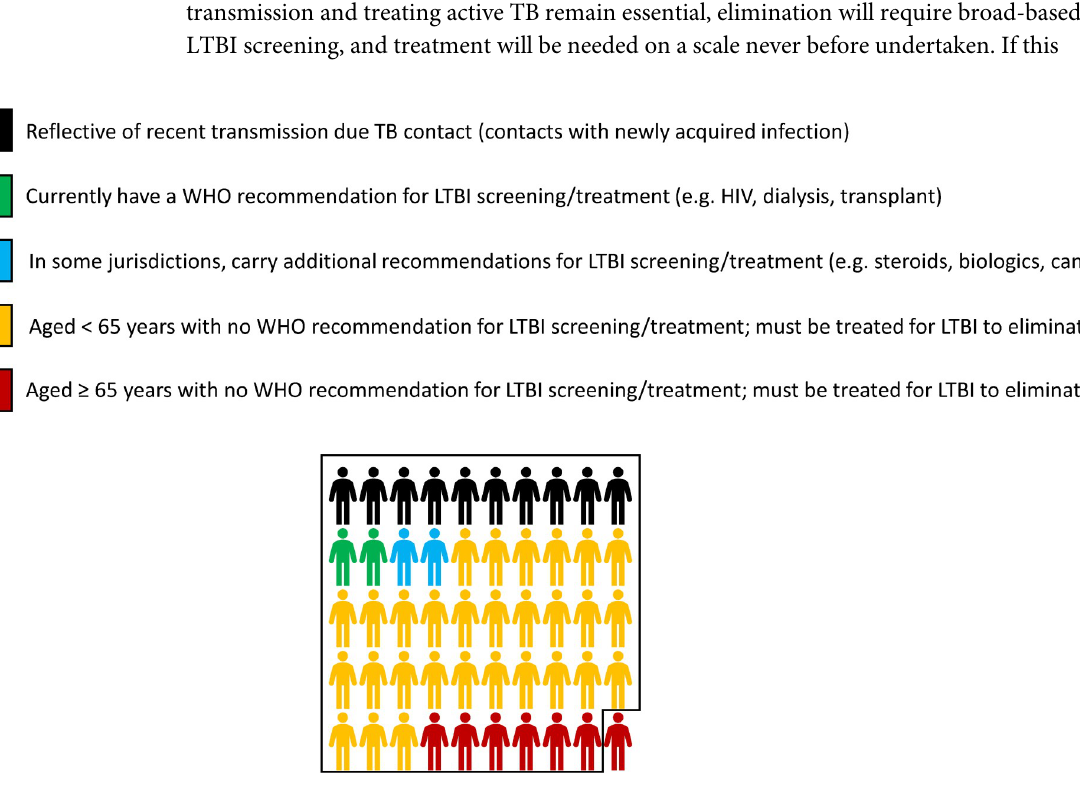
Fig 1. What would it take to eliminate TB in Canada? A pictorial description. Shown is the distribution of TB disease among risk groups. In Canada and other low-incidence countries, 70% of TB disease arises in foreign-born persons. Thus, 7 out of every 10 people in this figure would be foreign-born; in some countries, these individuals may also carry national recommendations for LTBI screening and treatment [10]. The box represents the 49 TB cases (out of every 50 now reported) that must be prevented in order to reach the elimination target of 1 case per million population [4,8]. HIV, human immunodeficiency virus; LTBI, latent TB infection; TB, tuberculosis; WHO, World Health